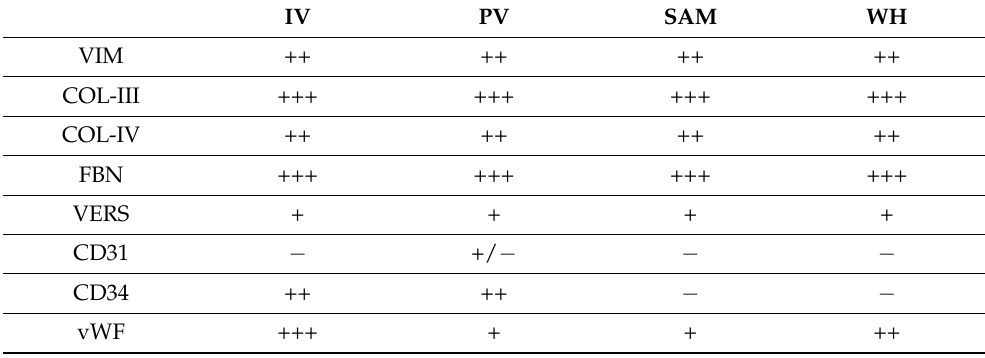
Table 2. Semiquantitative analysis of vimentin, four fibrillar (collagen type III—COL-III, and collagen type IV—COL-IV), and non-fibrillar (fibronectin—FBN, and versican—VERS-) components of the ECM and three vascular markers (CD31, CD34, and von Willebrand factor—vWF) in cells isolated from each zone of the hUC and kept in ex vivo culture (hUC-MSC). IV: intervascular zone;